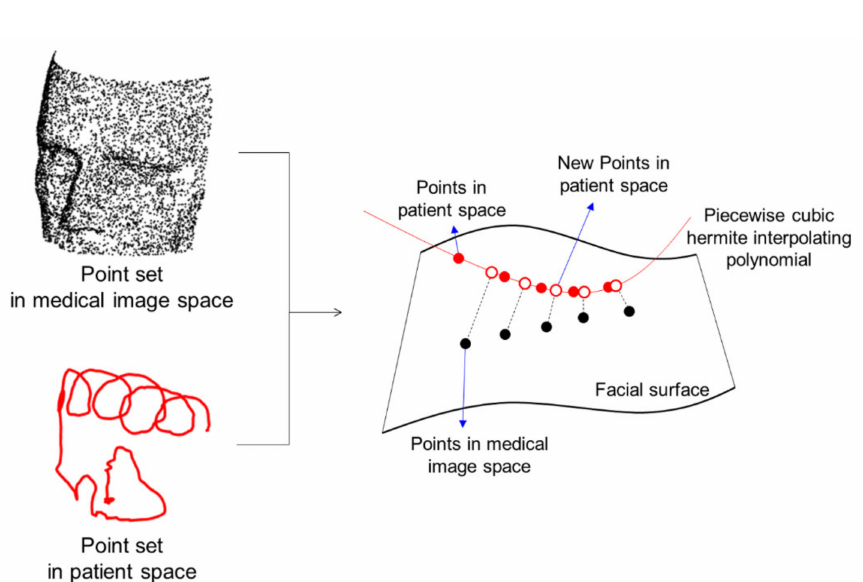
Figure 2. Refinement of the point set in patient space using a piecewise cubic Hermite interpolat- ing